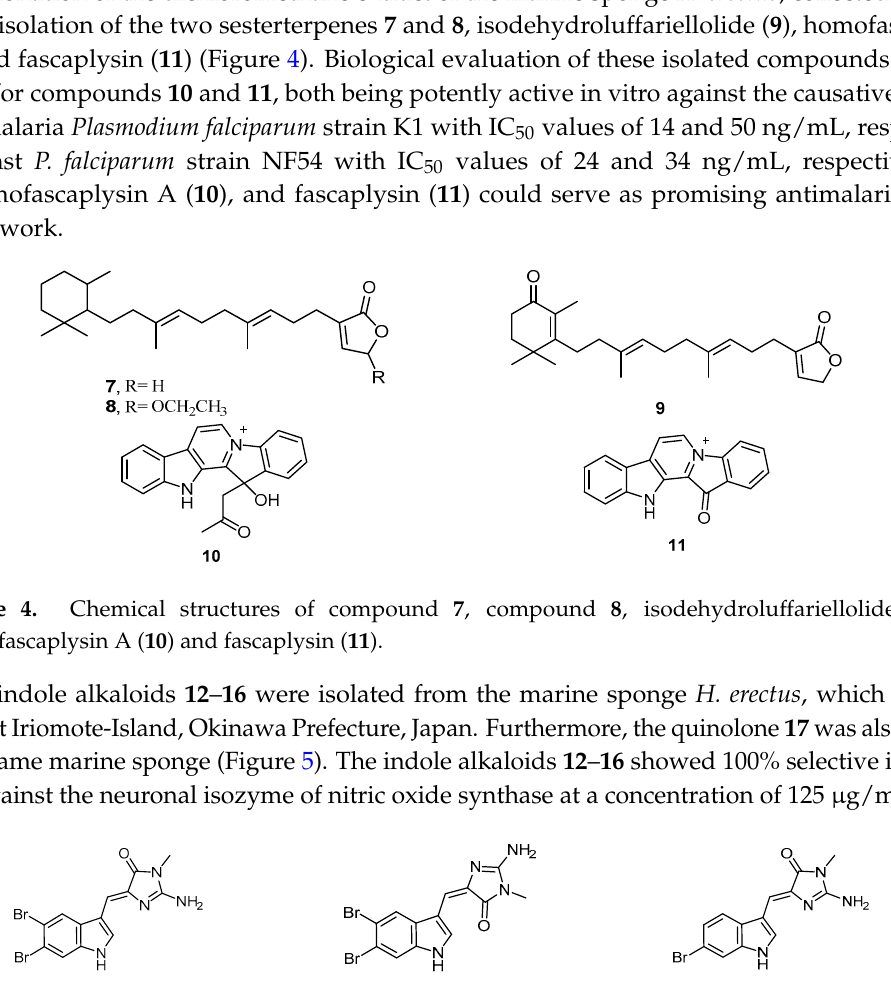
Figure 3. Chemical structures of sesterstatin 4 ( 5 ) and sesterstatin 5 ( 6 ).